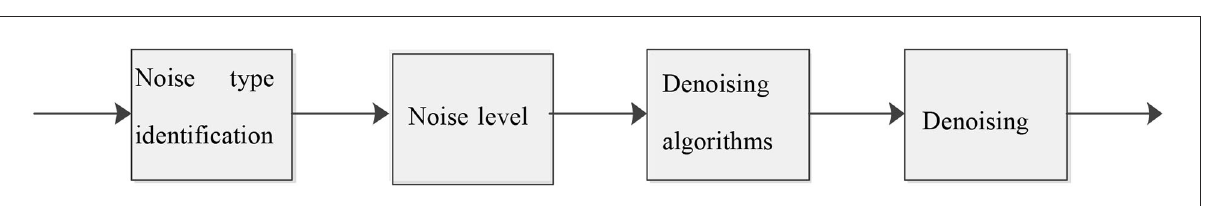
FIGURE7 The flowchart of image denoising.